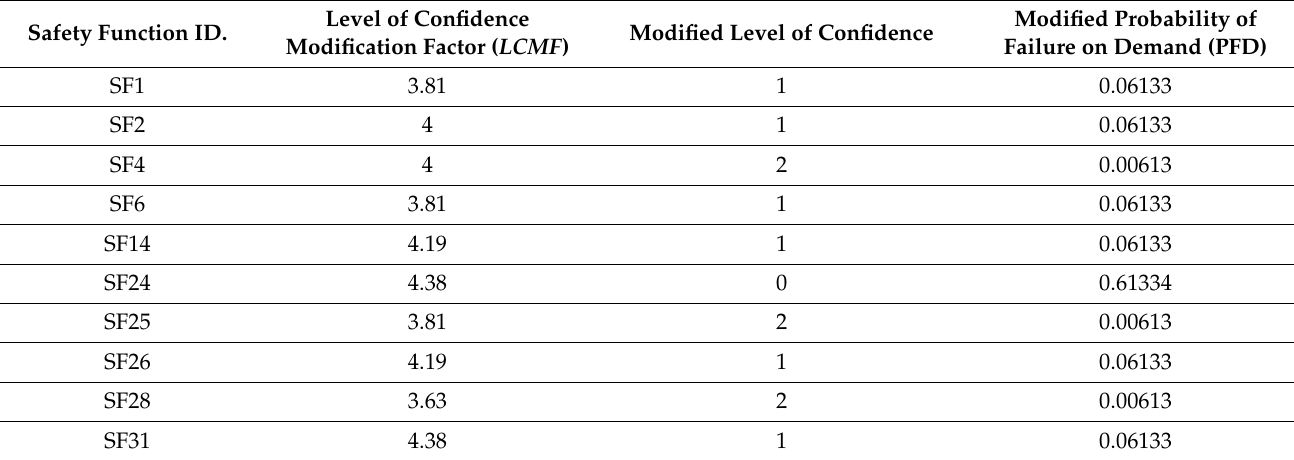
Table 7. Modified Level of Confidence (LC) for a Management Modification Factor ( MMF ) indicating low management performance, i.e., Score of the Management Modification Factor ( SMMF ) = 5.5. Safety Function